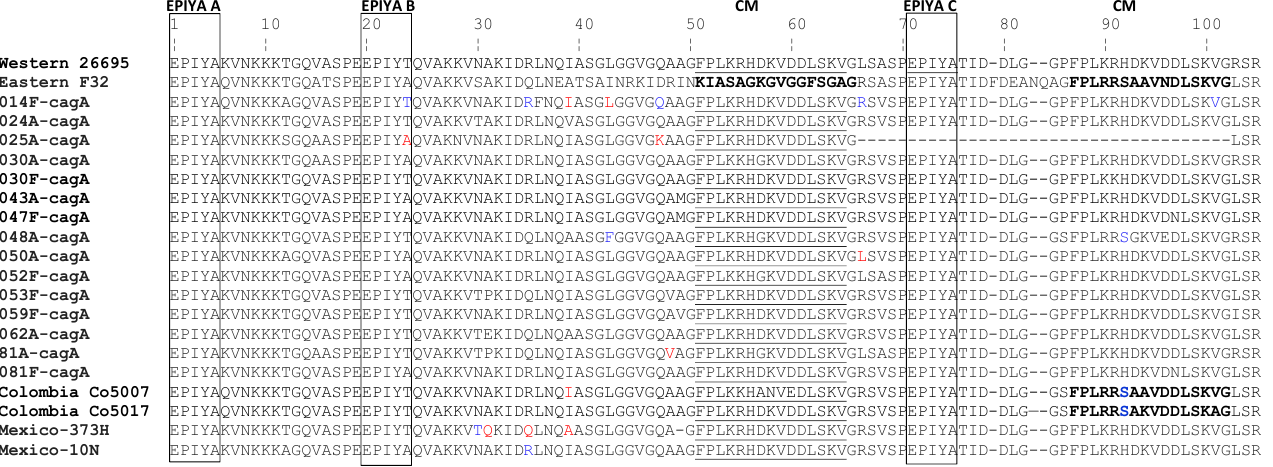
Figure 1. Amino acid sequence of the CagA 3’ terminal region from strains containing three EPIYA motifs. The reference strain F32 was isolated from a Japanese patient and it is representative of an Eastern sequence (ESS; AAF17597.1). The reference strain 26695 (NP207343.1) is representative of a Western CagA-specific sequence (WSS). The strains Co5007 (EU251000.1), Co5017 (EU250993.1) and 373H (JN390445.1) and 10N (JN390446.1) were isolated from indigenous groups in Colombia (Co) and Mexico, respectively. Boxes illustrate the regions containing the EPIYA domains and underline shows the cagA multimerization motif (CM).